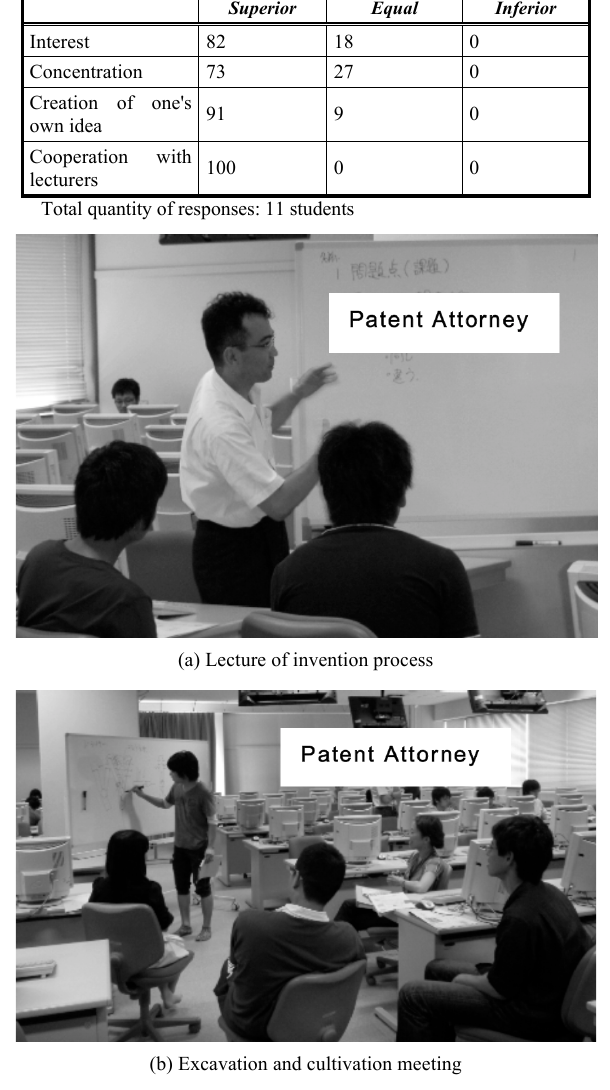
Figure 3. Pictures of seminar on creation of intellectual